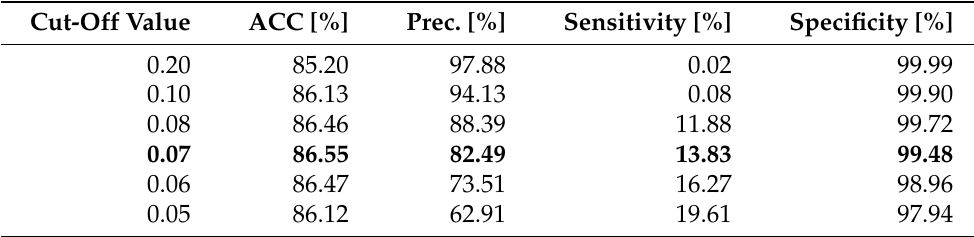
Table 1. Base algorithm results. The cut-off value is the mean value of the amplitudes of the standardized spectrogram, above which the algorithm considers the frame a bowel sound.